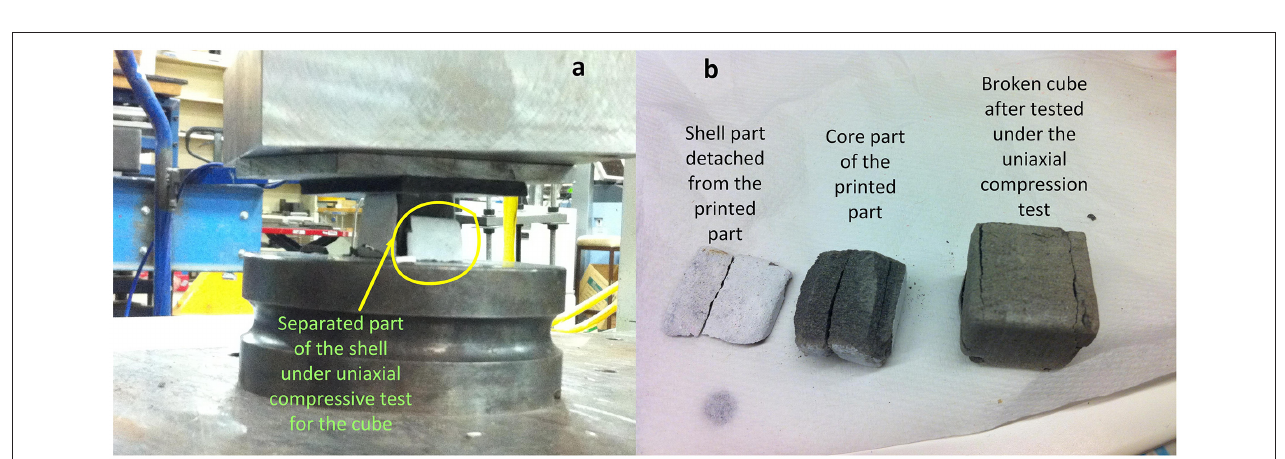
FIGURE 6 | Printed cementitious cube via inkjet 3D printer: (a) Compressed under a uniaxial load, (b) crack and detach of the shell and core